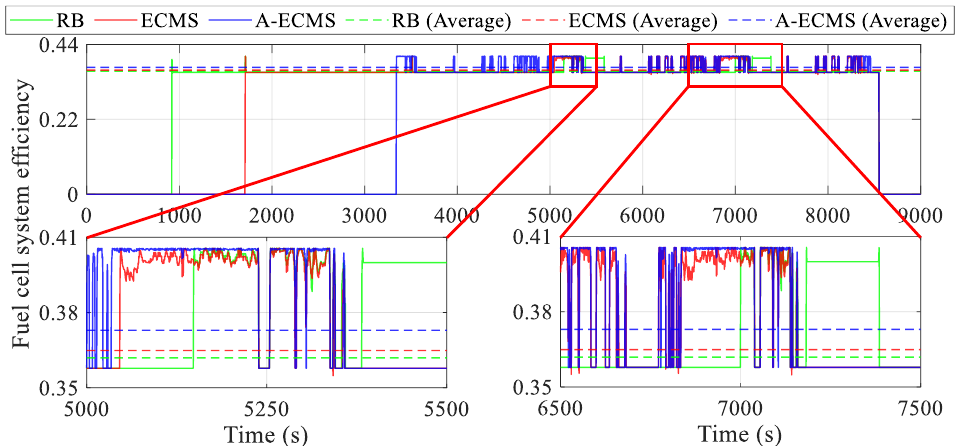
Figure 12. Curves of the fuel cell system efficiency using different methods.